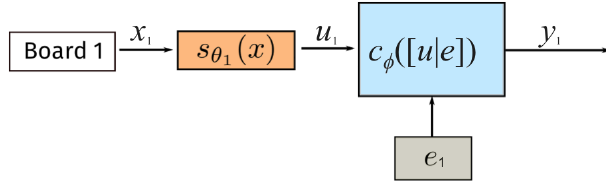
Figure 4. Architecture of the split-NN model in deployment (test- ing). Each air quality sensor has a board-specific model s θ normalizes a given sensor’s output ( x ) to an intermediate represen- tation from all sensors ( u ). The intermediate representation is com- bined with environmental data ( e ) and input to the global model c φ